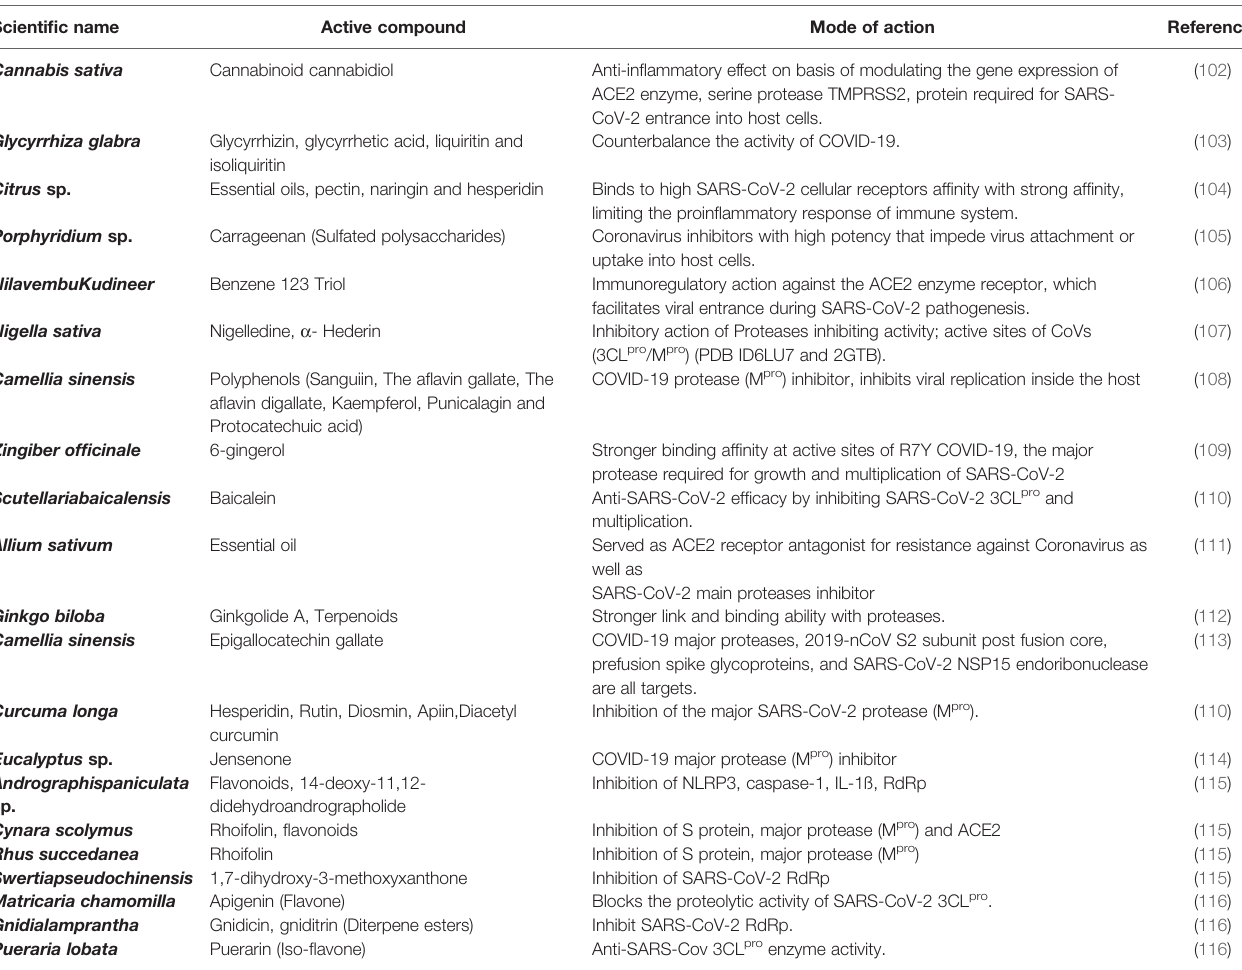
TABLE 2 | Applications of medicinal plants and herbs as possible therapeutics against COVID-19 infection.